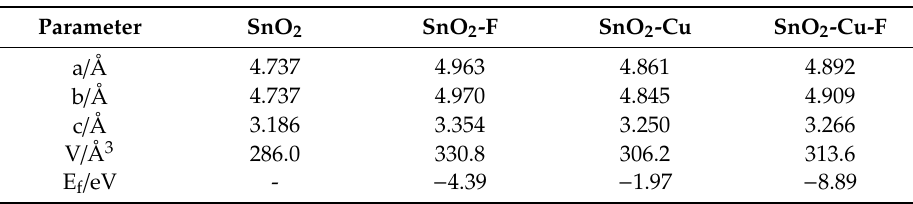
Lattice constant, volume, and doping formation energy of SnO 2 under di ff erent doping